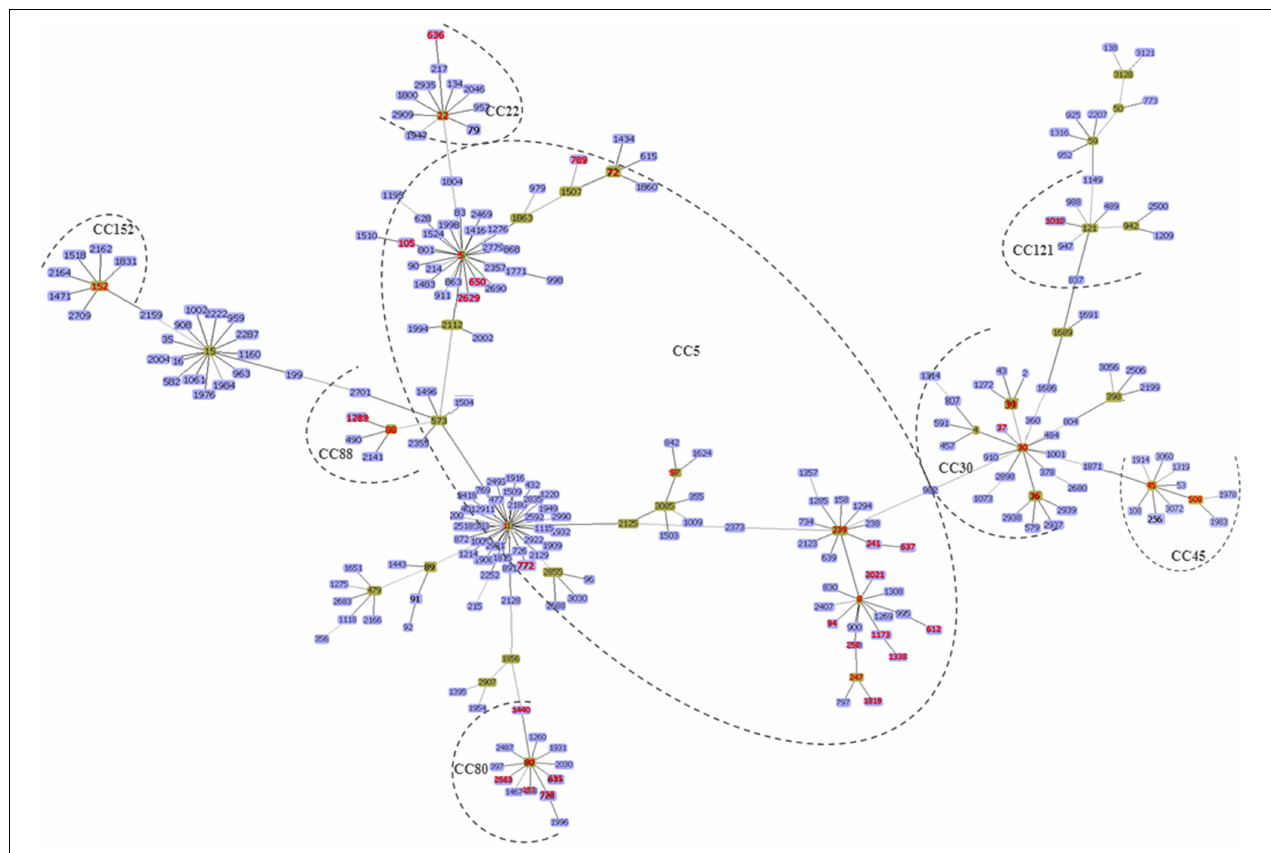
FIGURE 3 | The minimum spanning tree was constructed by the goeBURST algorithm using the Phyloviz software v1.1 (http://www.phyloviz.net/). The allelic profiles were downloaded from the MLST website (http://saureus.mlst.net/) which included the MRSA sequence types (STs) described in this review as well as 223